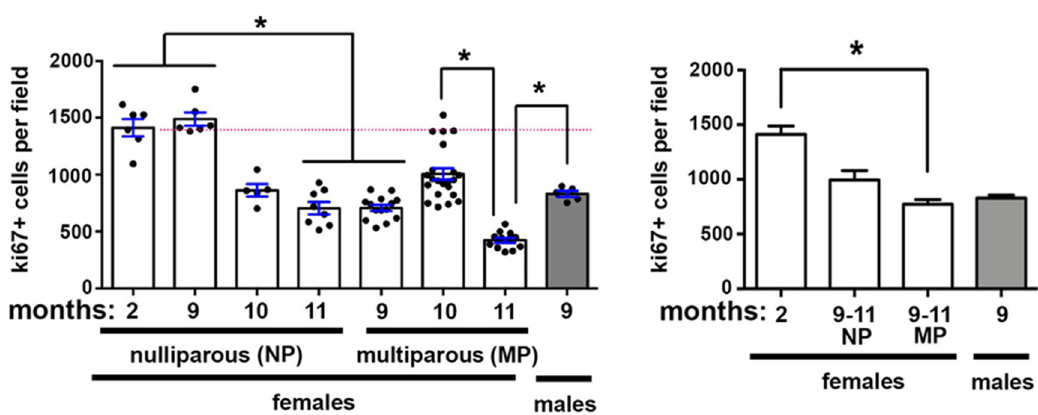
Figure 2. Corneal epithelial cell proliferation decreases after 9M as male and female mice age. The number of proliferating cells within the corneal epithelium was assessed by counting the mean number of ki67 + cells / field; 10 fields were assessed per cornea. On the left are data from each NP and MP age assessed. On the right, cell proliferation data are clustered for 9–11M NP and MP female mice. Asterisks indicate significant di ff erences with p values < 0.05. The dotted pink lines highlight cell proliferation for the 2M NP controls.